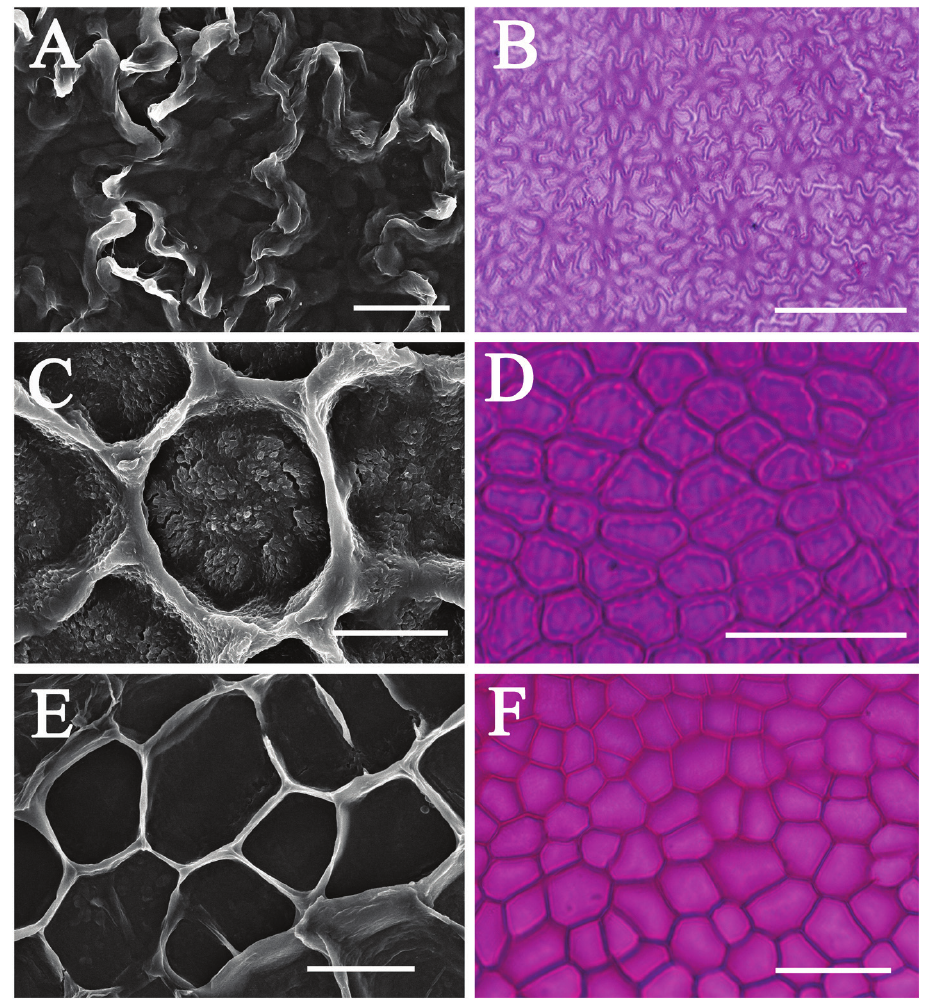
Figure 5. A comparison between the upper leaf epidermis under scanning electron microscope and light microscope, SEM images of internal surface of the upper leaf epidermis displaying the possible origin of the reticulations of the periclinal walls A, B C. aromaticum C, D C. daphnoides E, F C. ilicioides. Scale bars: 10 μm; ( A, C ); 20 μm; ( E ); 50 μm ( B, D, F